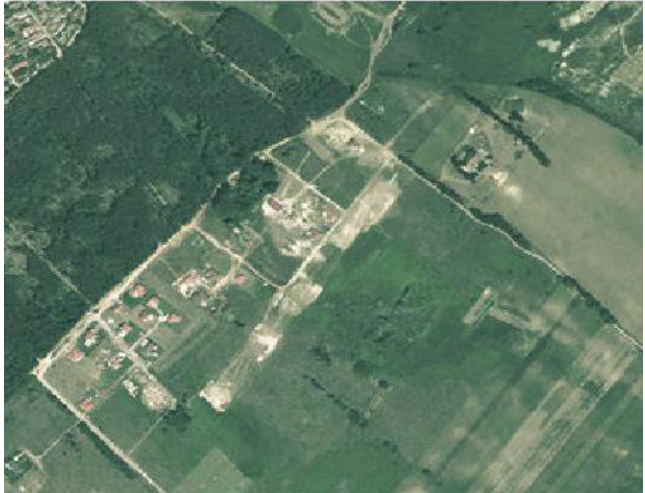
99.36 Figure 13. Comparative analysis of the SVD dataset.